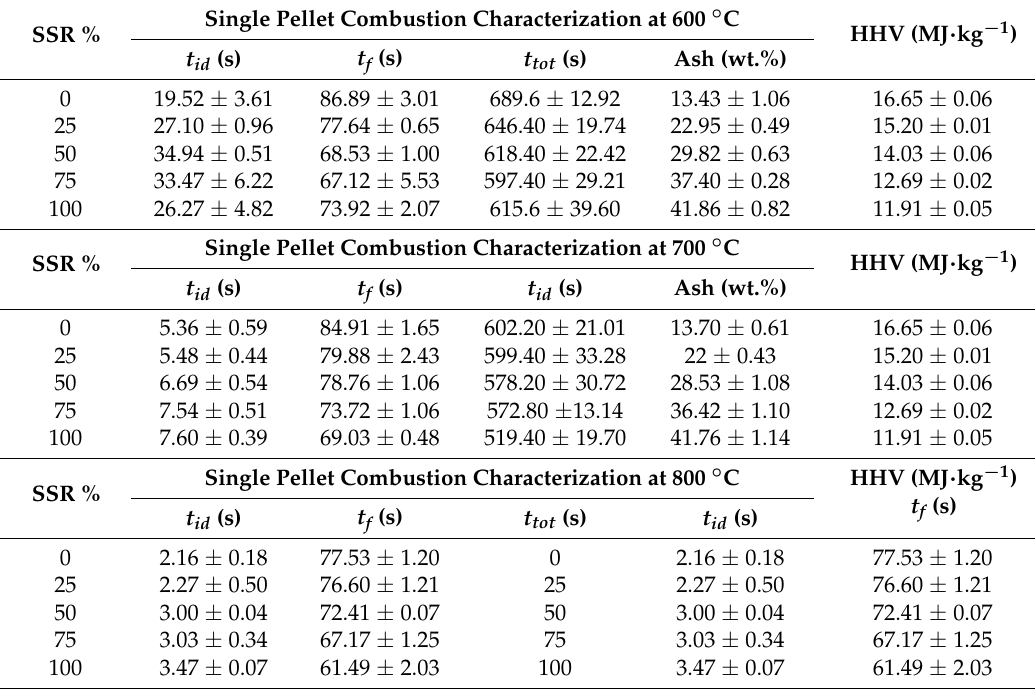
Table 7. Single-pellet combustion characterization for various sludge-shiitake